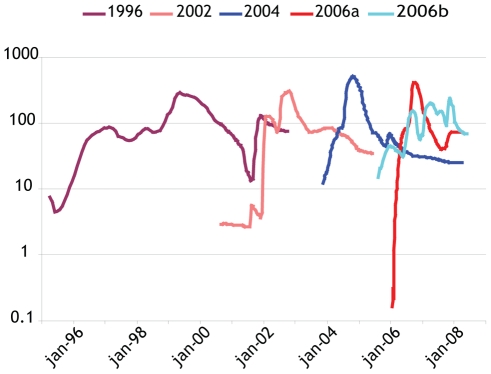
Bayesian Skyline Plots of different GII.4 variants analyzed separately.Only the mean population sizes through time were plotted for clarity.